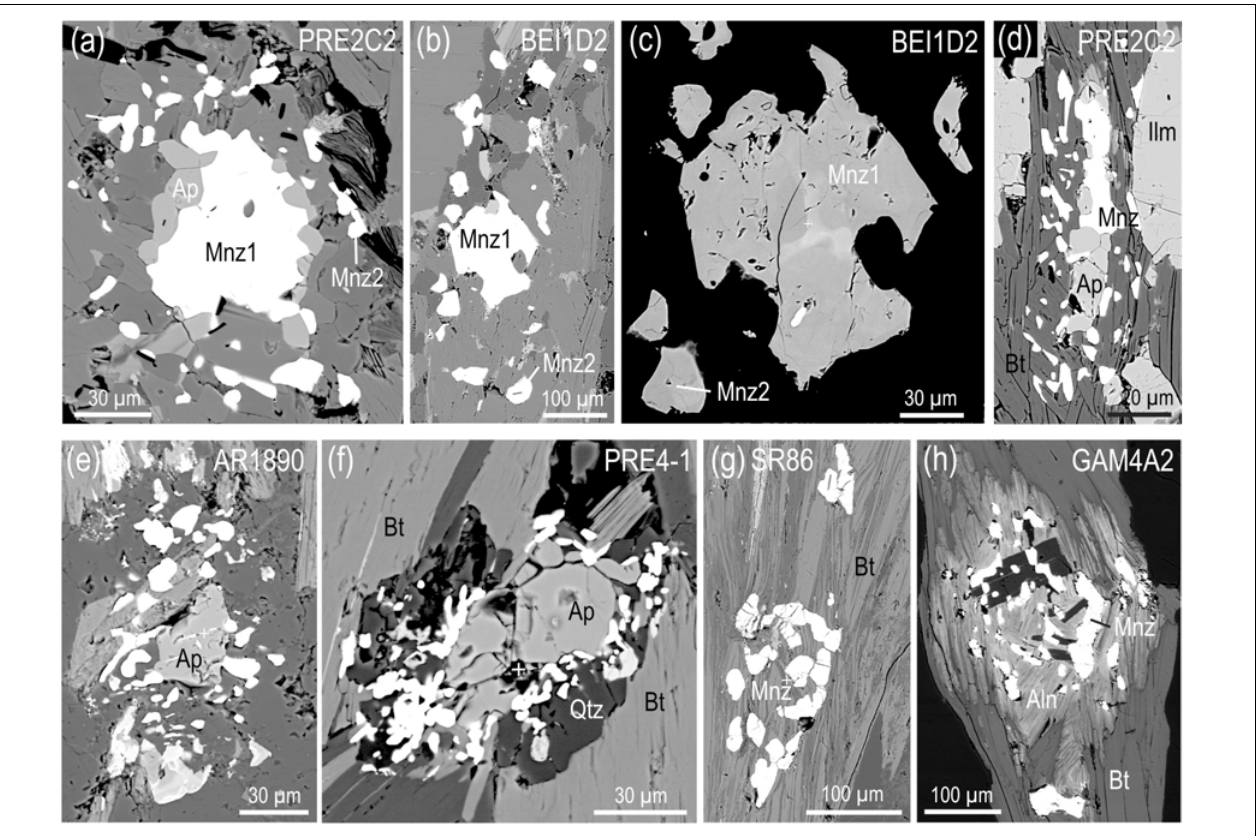
FIGURE 7 | Satellite microstrutures of monazite as defined by Finger et al. (2016). (a) Typical satellite microstructure with core monazite (Mnz1) and attached relicts of the apatite (Ap) corona, surrounded by a ring of small monazites (Mnz2) which apparently crystallized from the former allanite corona (Finger et al., 2016). (b,c) Elongated satellite structure with amoeboid core monazite in micaschist from the polymetamorphic Saualpe basement (Schulz, 2017). (d) Elongated satellite microstructure with apatite and monazite in the core. (e,f) Small satellite monazites surrounding an apatite core in micaschists from the Aiguilles Rouges Massif (Schulz and von Raumer, 2011) and from Saualpe. (g,h) Arrangements of small monazite grains resembling satellite